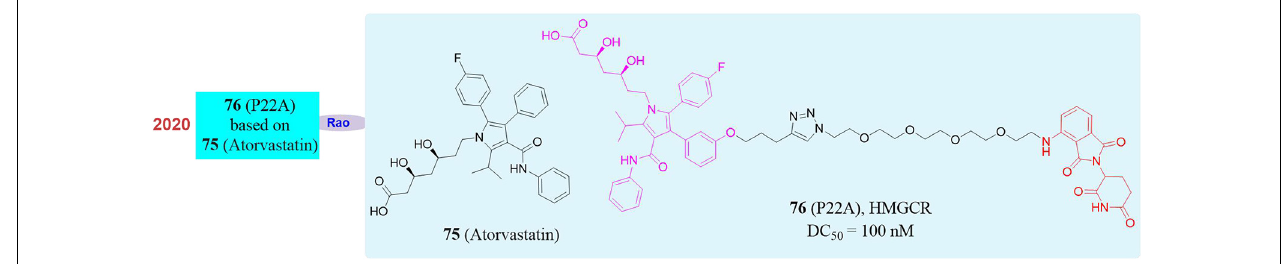
FIGURE 13 | Structures of HMGCR inhibitor and